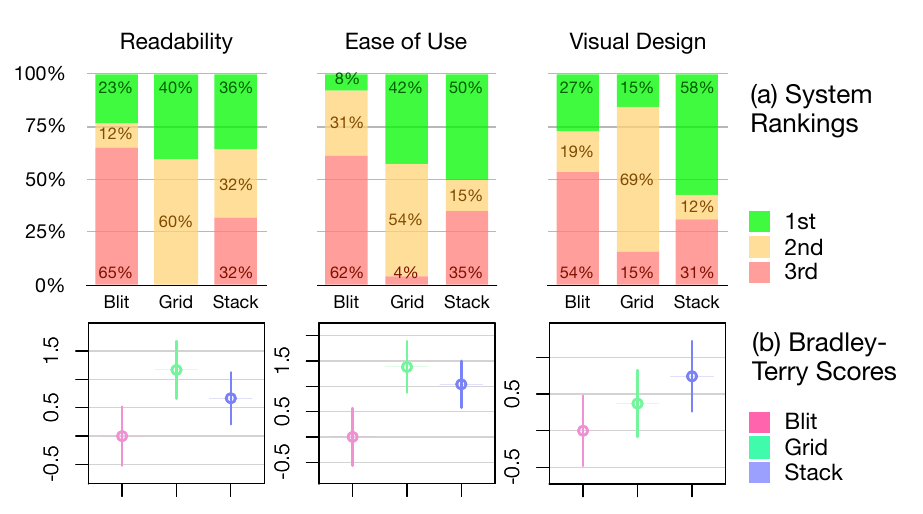
Figure 5. ( a ) How often (in percent) each system was ranked first, second, or last in terms of readability (legibility of the map layers), ease of use, and visual design by the users; ( b ) Pairwise comparisons scored with the Bradley–Terry